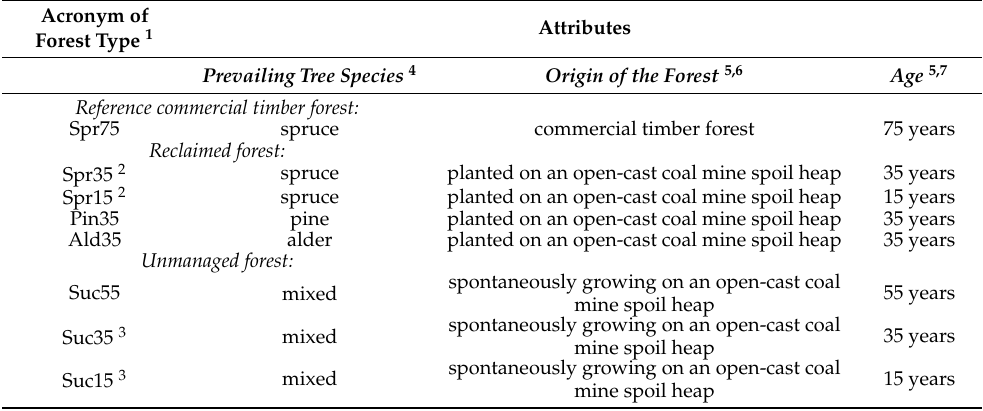
Table 1. Evaluated forest